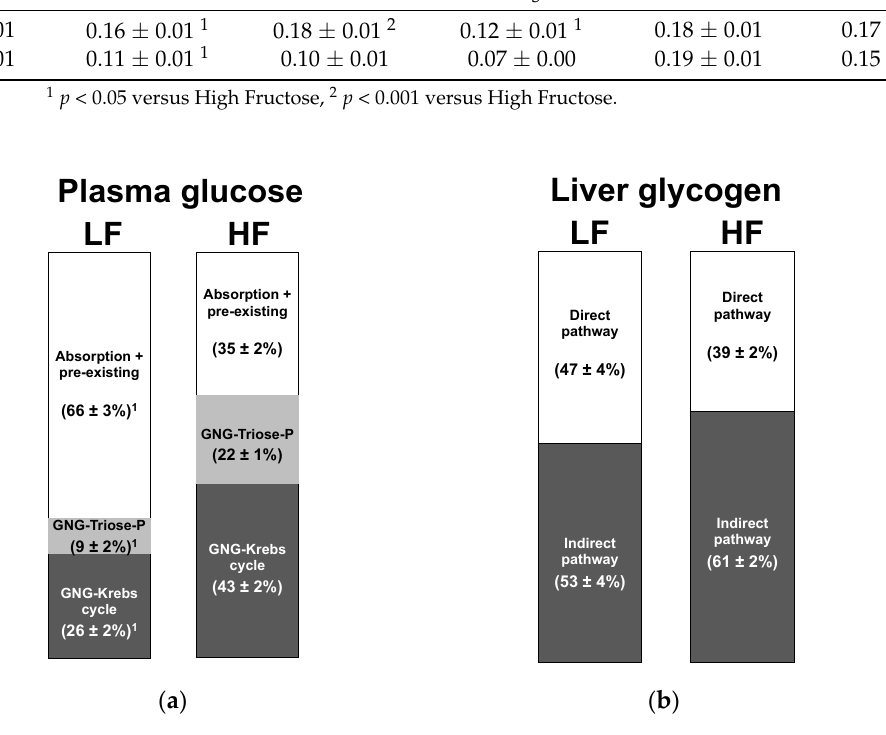
Figure 5. Sources of ( a ) plasma glucose appearance and ( b ) hepatic glycogen synthesis following meals supplemented with 50 g sugar containing 5/95 fructose/glucose (low fructose, LF) and 55/45 fructose/glucose (high fructose, HF). 1 p < 0.01 versus the corresponding HF values.